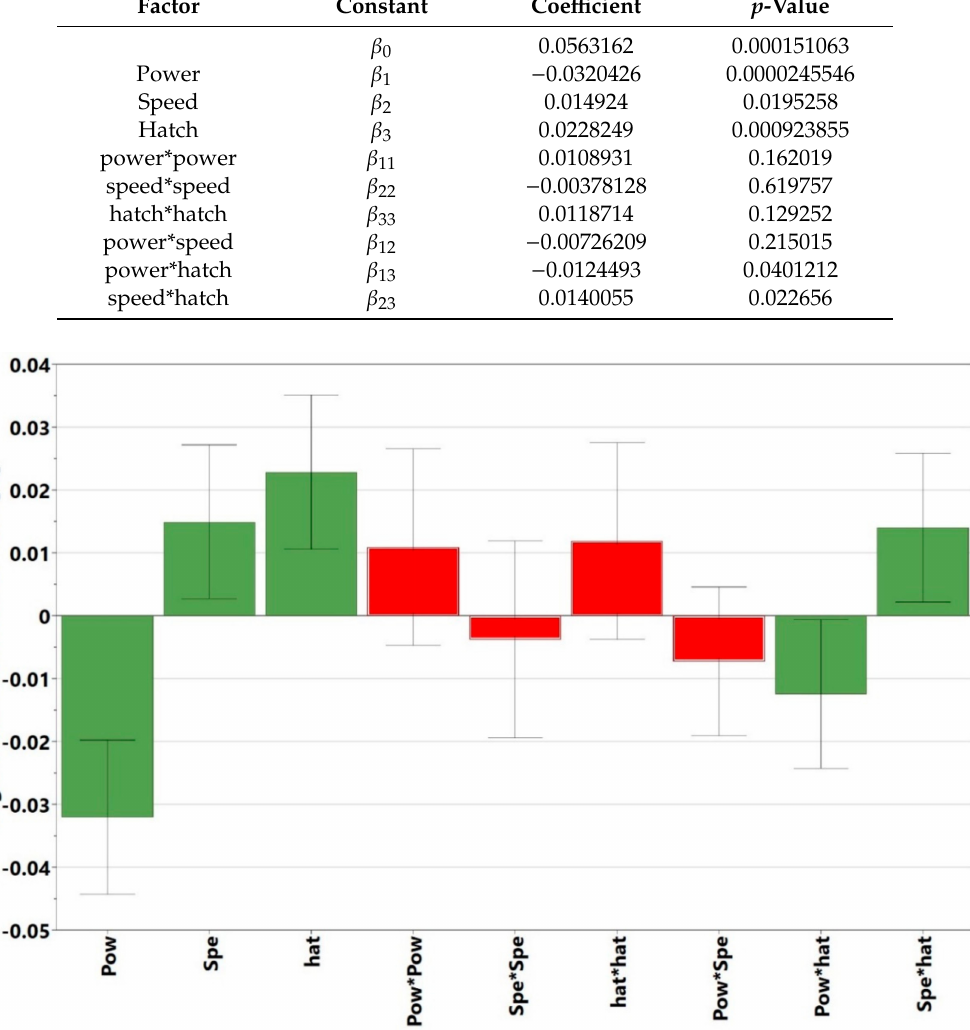
Figure 5. Regression coe ffi cients for di ff erent factors and interaction of factors a ff ecting void content (green bars indicate significant factors, while red bars indicate non-significant